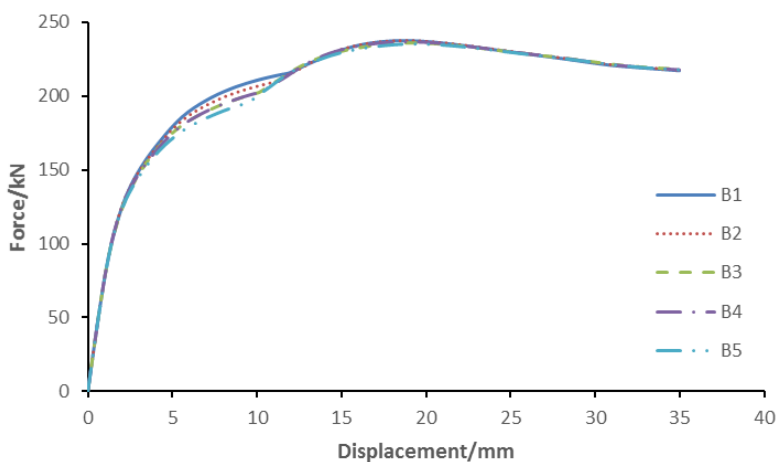
Figure 22. Force-displacement curves.